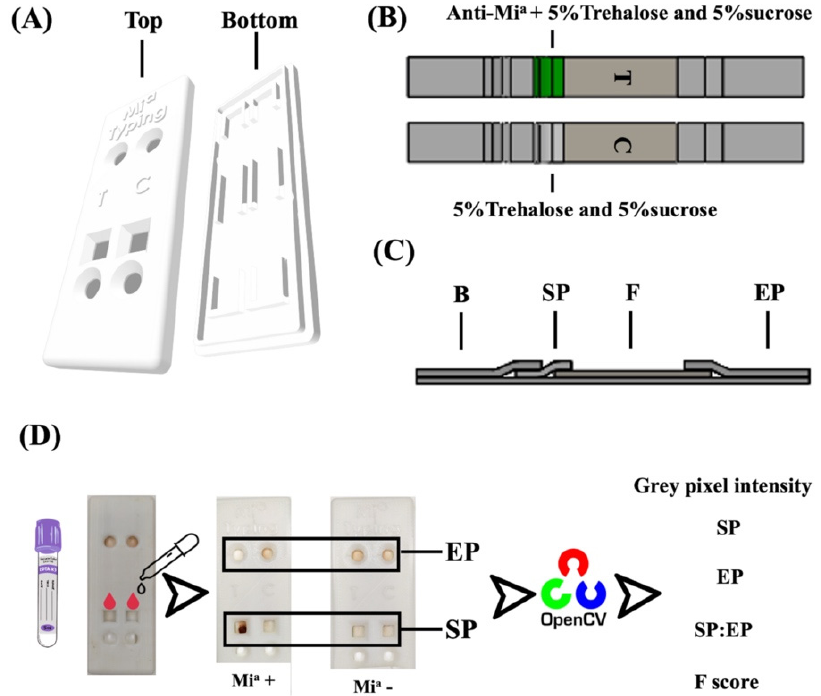
Figure 1. Illustration of minor blood group phenotyping concept: ( A ) top and bottom 3D cassette and PAD; ( B ) PAD–Mi a phenotyping for test and control line; ( C ) composition of PAD–Mi a phenotyping: B: buffer part; SP: sample part; F: flow part; and EP: elution part; ( D ) image processing for creating analysis criteria.